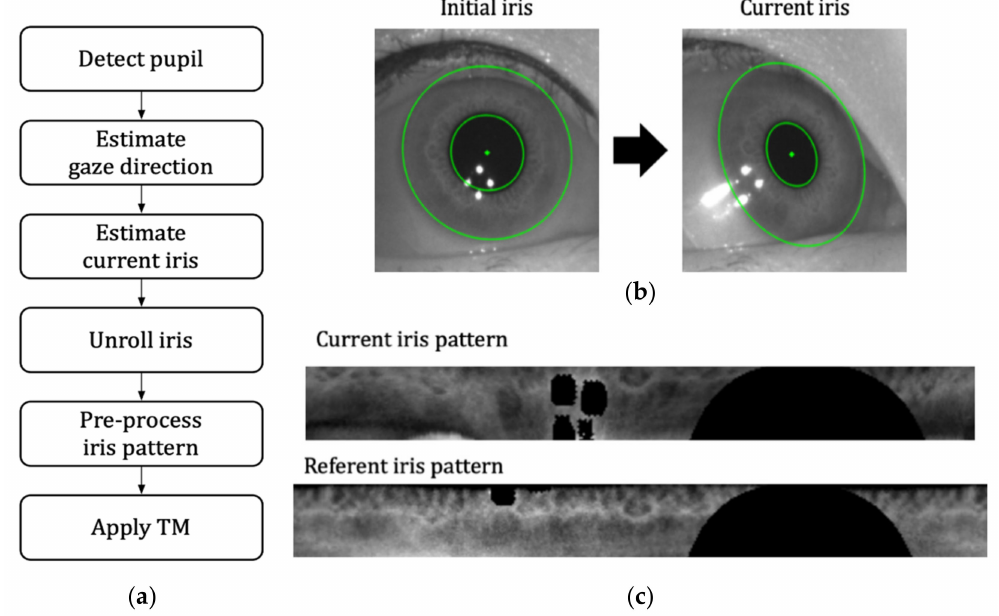
Figure 1. ( a ) Main steps of the proposed method of eye torsion measurement; ( b ) the initial iris is transformed according to the gaze direction to estimate current iris; ( c ) the TM algorithm is applied to measure the shift of current unrolled iris pattern in respect to the referent